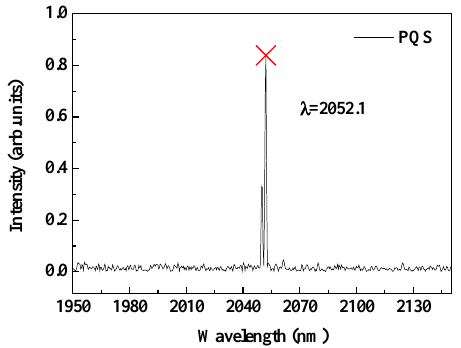
Figure 10. Laser spectral in passive Q-Switched (PQS) mode.